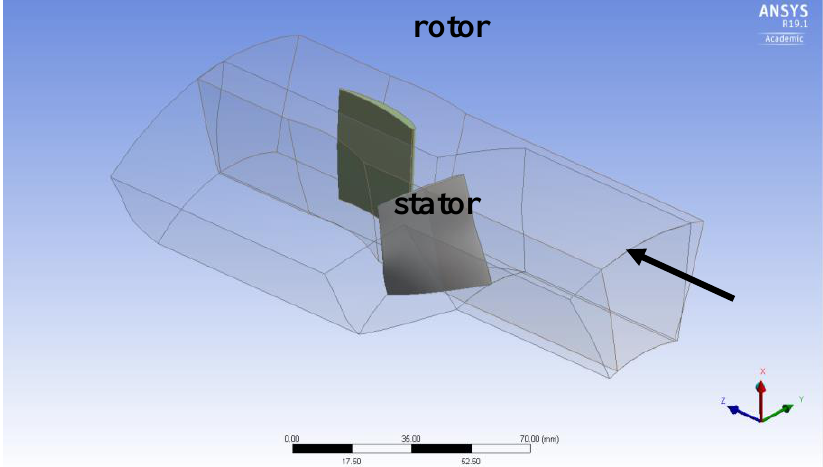
Figure 23. Preliminary view of the rotor and stator.